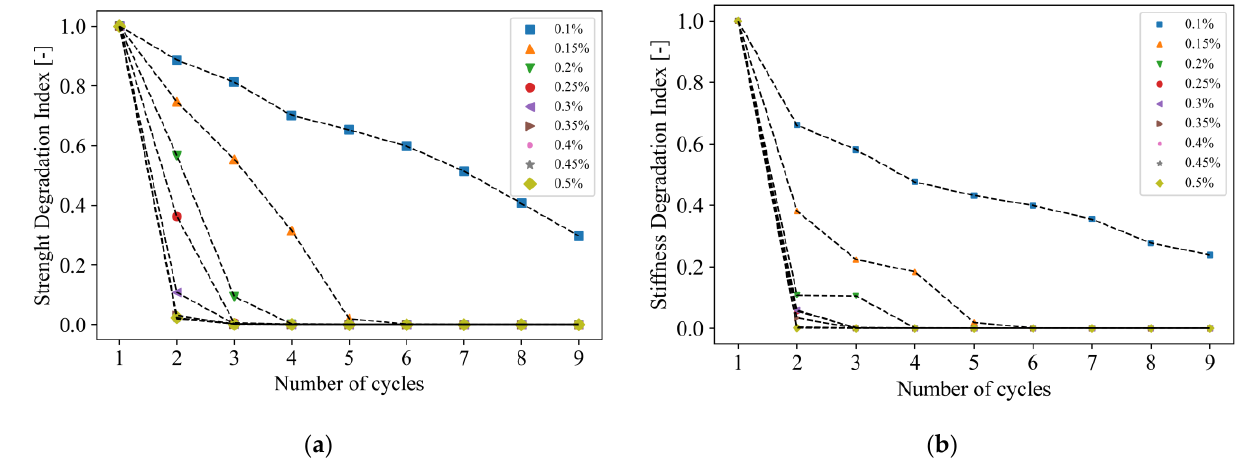
Figure 9. Cyclic Degradation Curves for the loose sand samples: ( a ) degradation of the soil strength; ( b ) degradation of the soil stiffness expressed as the initial tangent shear modulus. ( b ) degradation of the soil stiffness expressed as the initial tangent shear